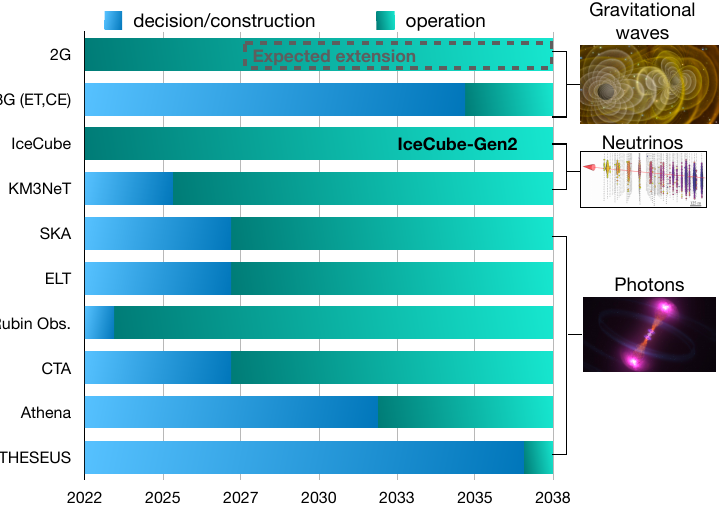
Figure 3. Planned timelines of the main failicities for Multi-Messenger Astronomy in the next decades with which THESEUS will operate in strong synergy (see Figure 2)